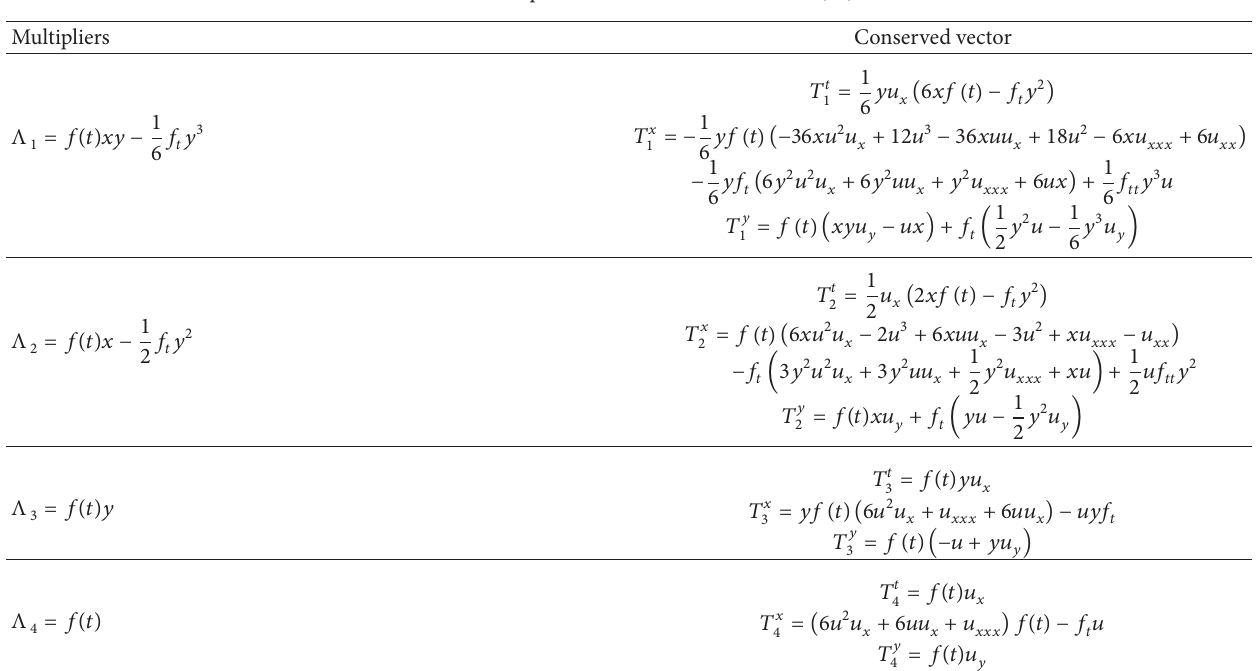
Table 2: Multipliers and conserved vectors for